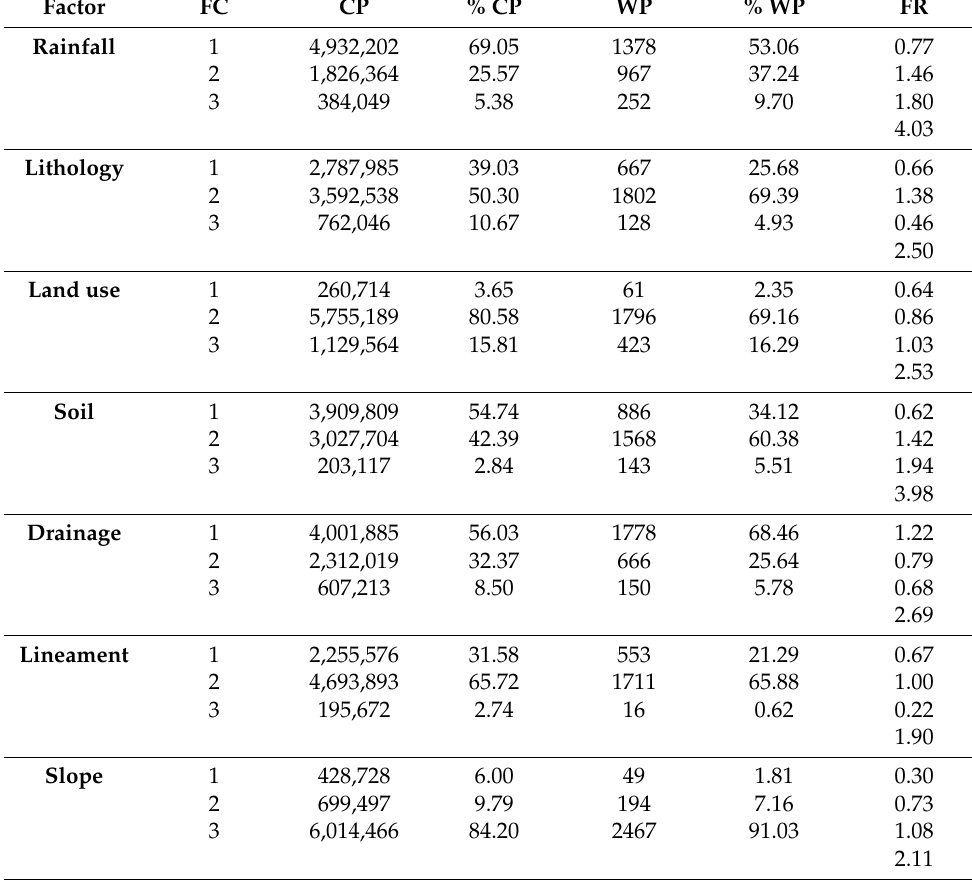
Table 8. Frequency ratio (FR) analysis for each of the factors and factor